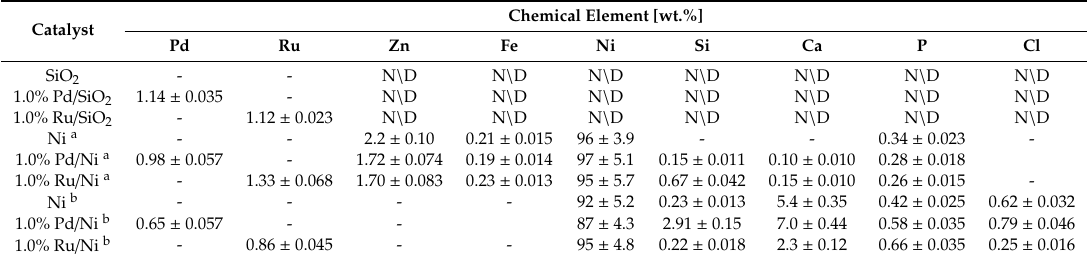
a \ Nanowires. b \ Nickel foam shape fitted to catalyst bed. N \ D—not